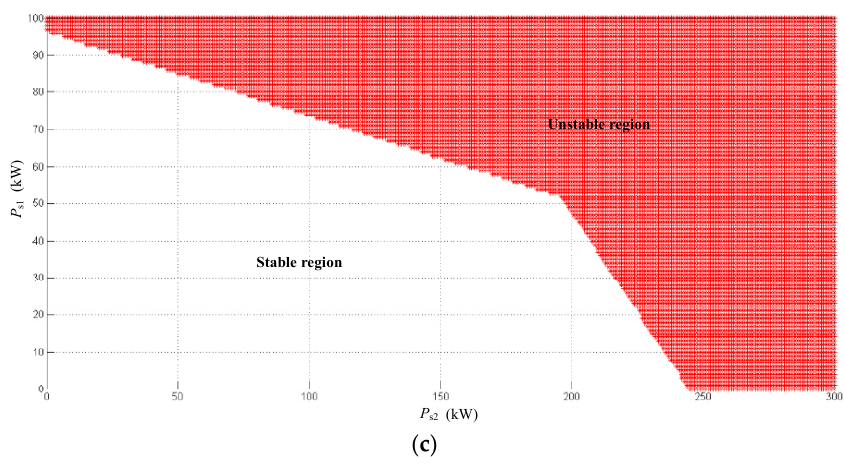
Figure 4. Stable operation boundary of slave VSC1 and slave VSC2 under three conditions: ( a ) P dc = − 30 kW; ( b ) P dc = 0 kW; and ( c ) P dc = 30 kW.